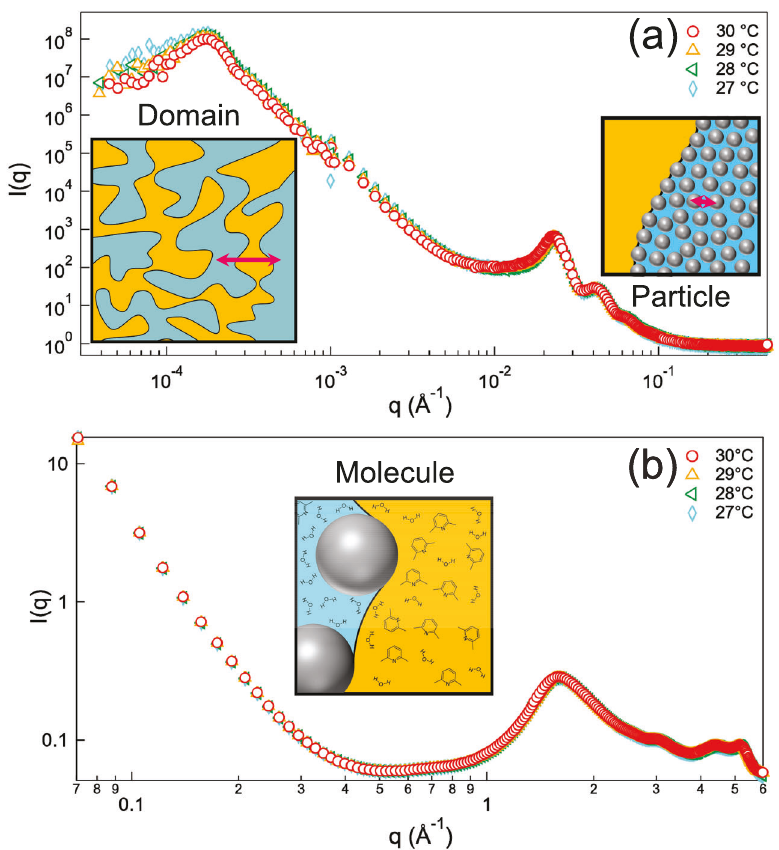
Fig. 2 Structure characterizations in multi-length scales using scattering techniques. The scattering pro fi les of SeedGel within the temperature range exhibiting tunable structural color characterized by a USANS/SANS and b SAXS/WAXS. The inset images show the schematic drawing of the structures at different length scales probed by different q -ranges. The solvent compositions in the particle-rich and solvent domains are different from each other and they are denoted with different colors. The error bars represent one standard deviation and are often smaller than the symbol